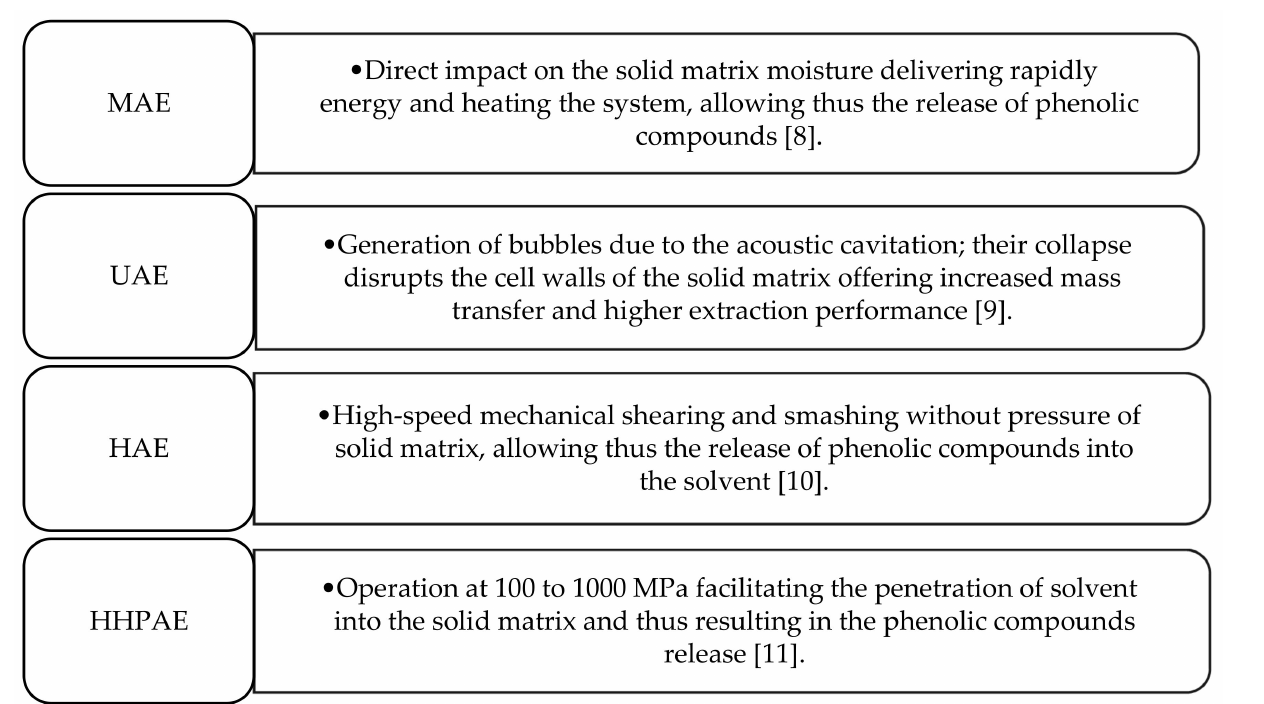
Figure 1. The main mechanism of action of assisted extraction techniques. MAE: microwave- assisted extraction; UAE: ultrasound- assisted extraction; HAE: homogenate- assisted extraction; HHPAE: high hydrostatic pressure- assisted